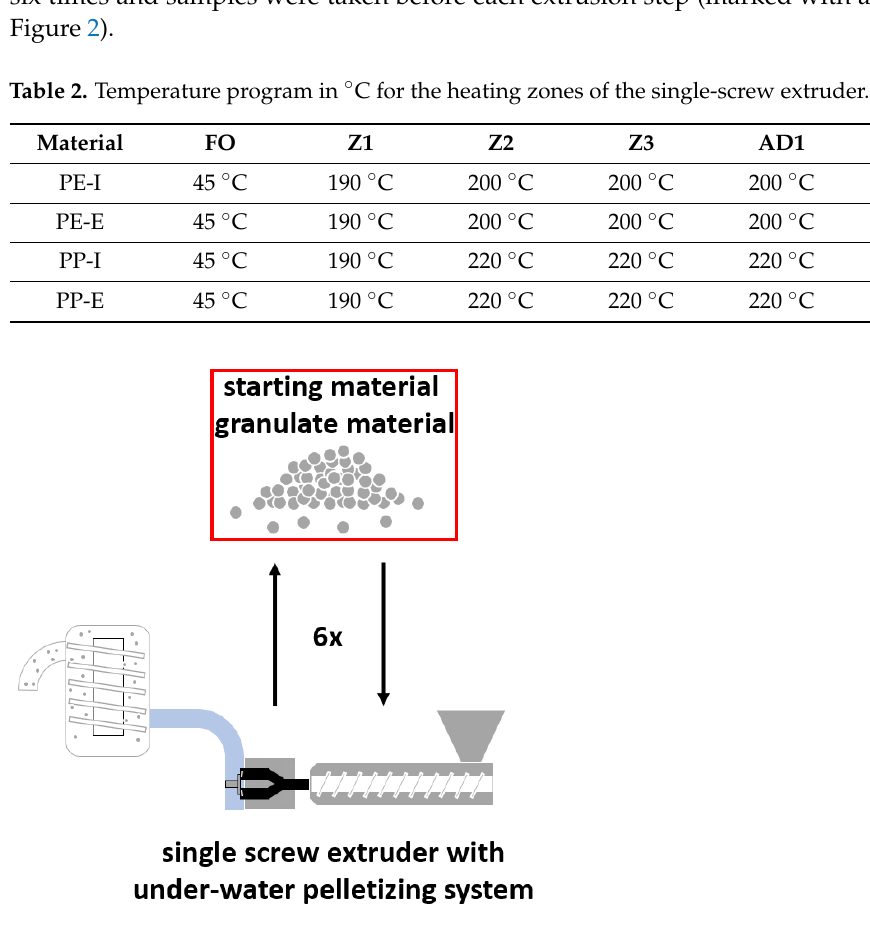
Figure 2. Schematic representation of the extrusion cycle (CL-E) using a 35/34D single screw extruder with an EUP 50 under-water pelletizing system.